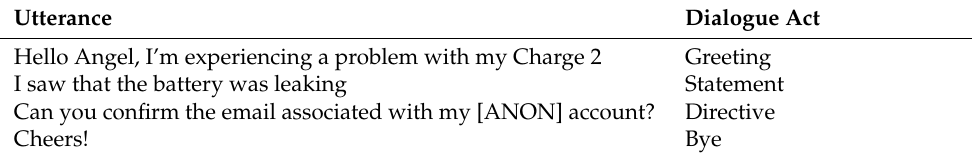
Table 4. Sample utterances and corresponding dialogue